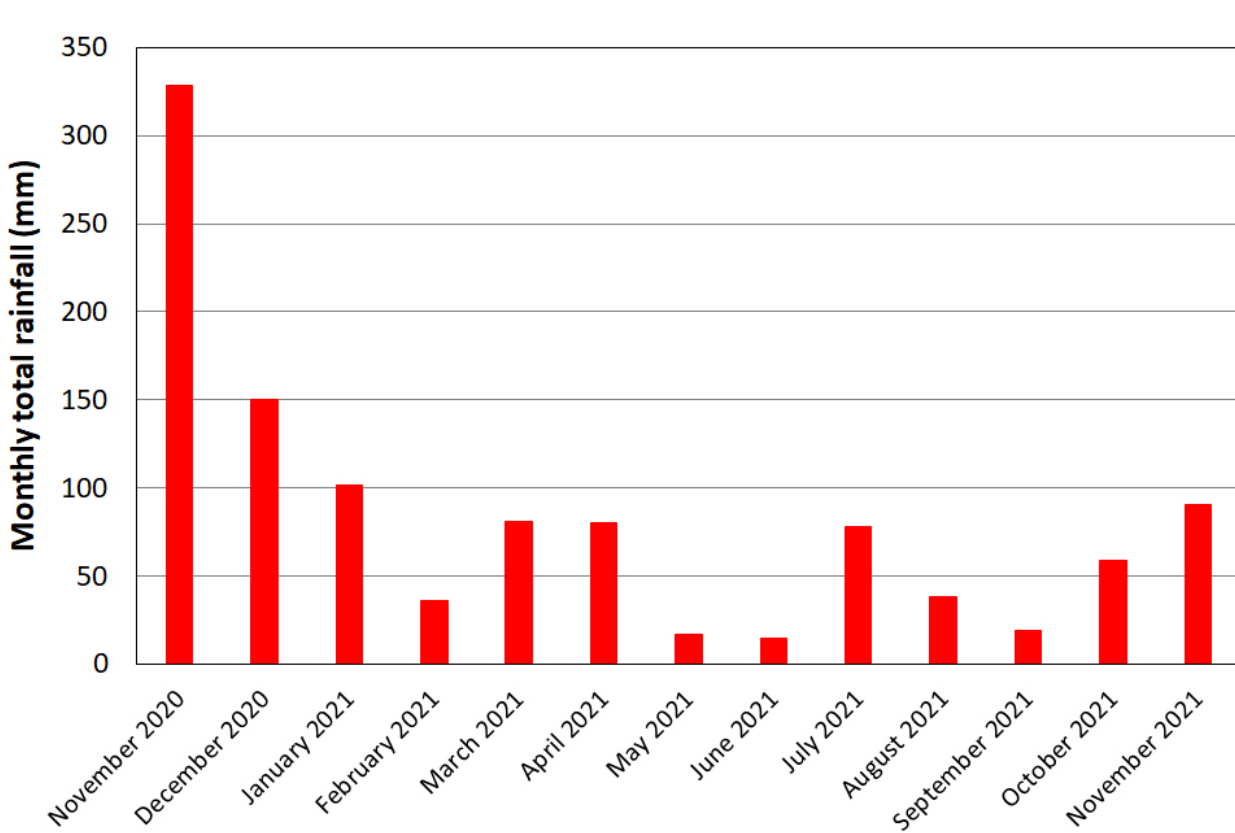
Figure 5. Diachronic comparison between the lakeshores.